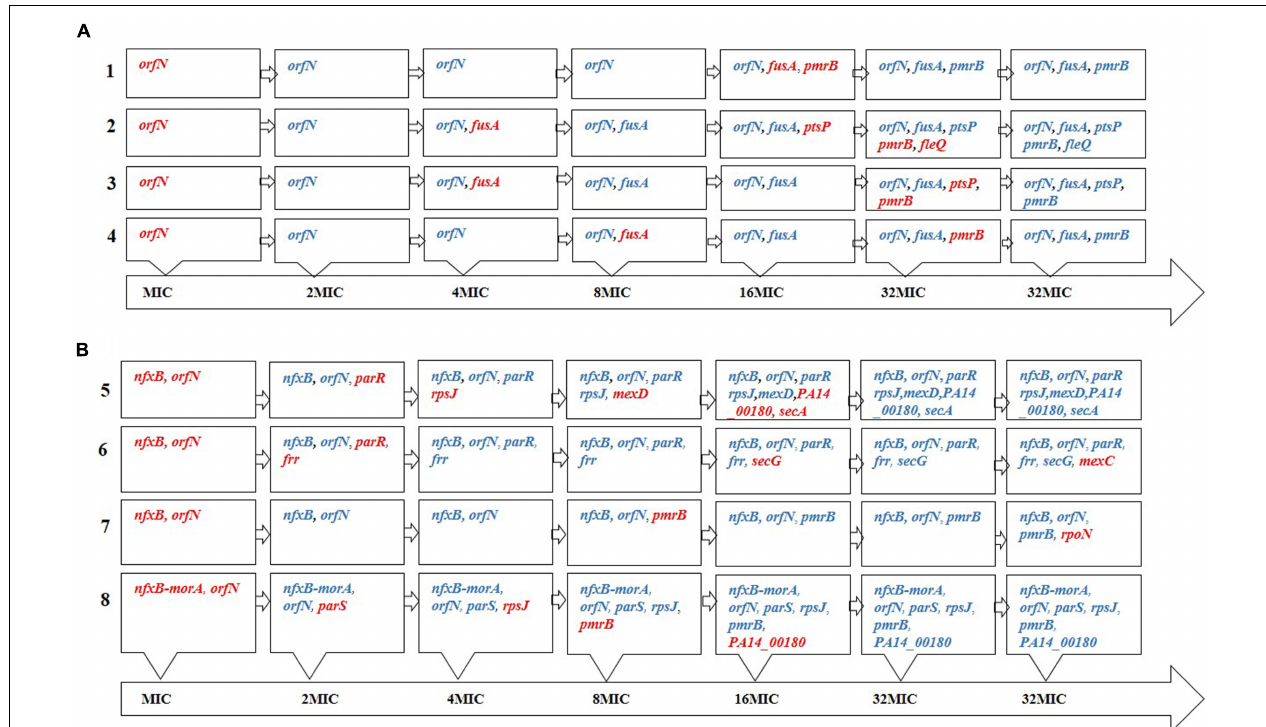
FIGURE 3 | Order of appearance of genetic changes. Order of appearance of (A) tobramycin and (B) tigecycline resistance mutations during the evolution process, as determined by PCR amplifications of known SNVs/MNVs in 32MIC populations. The names of the genes in red indicate that these mutations appeared in this step. Once a mutation appears it remains in the population until the end of the evolutionary period. We cannot discard that other mutations may have appeared and not fixed over the 35 days evolution